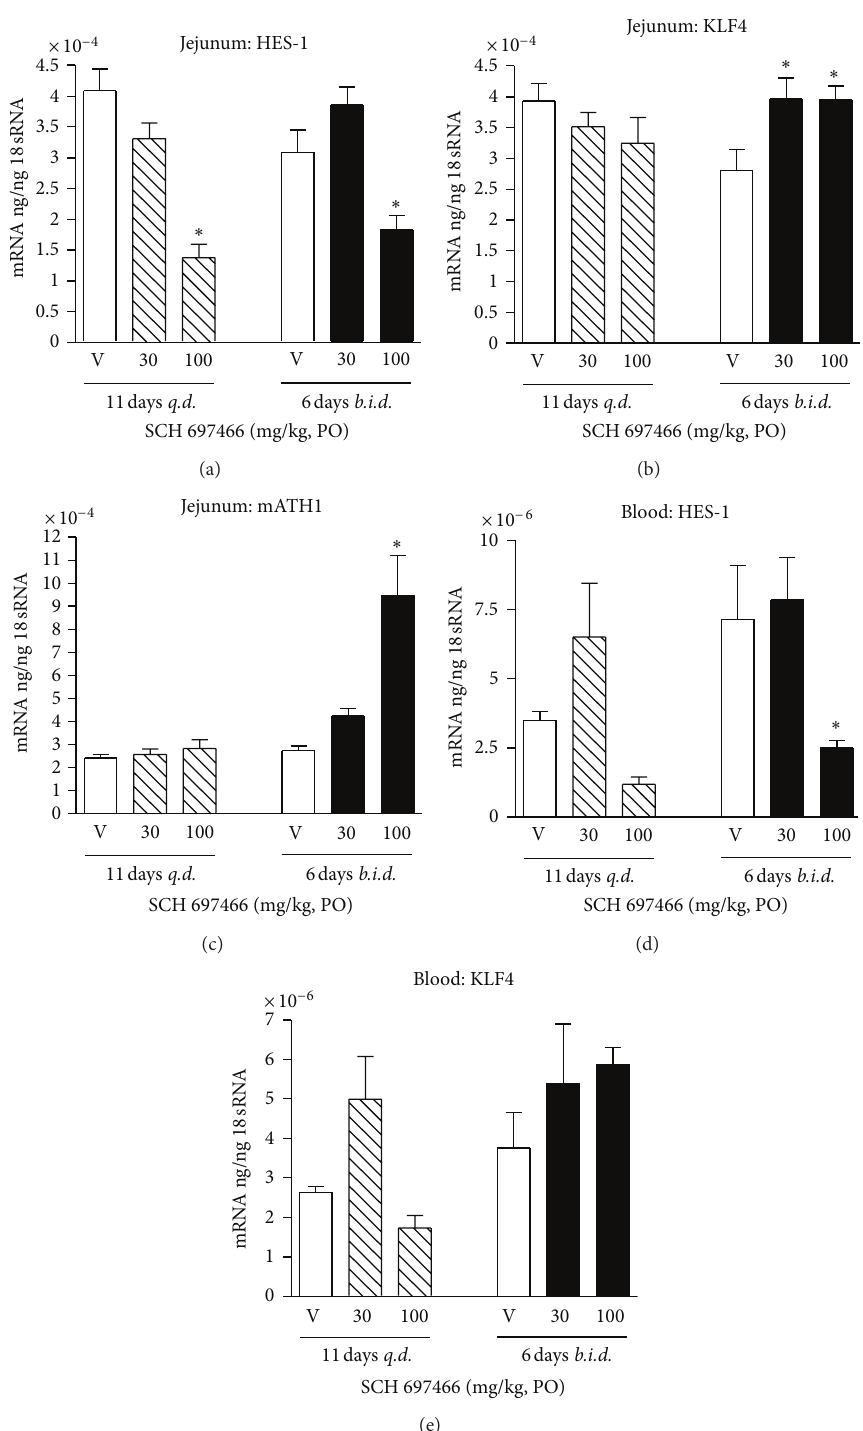
Figure 6: (a) HES-1, (b) KLF4, and (c) mATH gene expression in the jejunum and (d) HES-1 and (e) KLF4 gene expression in white blood cells following 11 days of q.d. administration (left side of graphs) or 6 days of b.i.d. administration (right side of graphs) of SCH 697466 in nontransgenic B6C3F1 mice. The final dose of SCH 697466 was given 3hr prior to tissue harvesting. ∗ 𝑃 < 0.04 versus vehicle, Dunnett post hoc